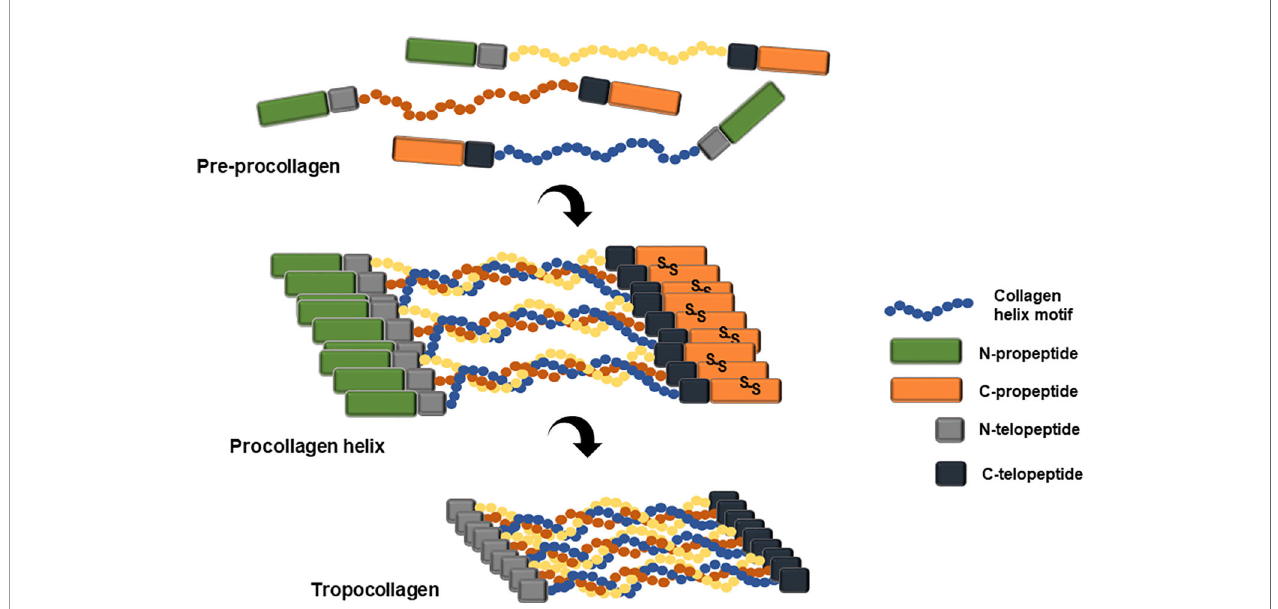
FIGURE 3 | Schematic representation of pre-procollagen structure and the formation of tropocollagen. Pre-procollagen is translated and post-translationally modi fi ed by various enzymes including the prolyl hydroxylase and lysyl hydroxylase. The mature procollagen initiates triple helix formation through C-propeptide alignment and disul fi de bond formation and twists along the helix motifs reach the N-propeptide. Several triple helix chains clusters align with each other and the N- and C- propeptide are cleaved by the N- and C- proteinase, either intracellularly or extracellularly, resulting in newly formed N- and C-termini, named N- and C-telopeptide. This tropocollagen helix stacks and packs into staggered collagen fi brils and alternately forms collagen fi bers through multiple crosslinking reactions.